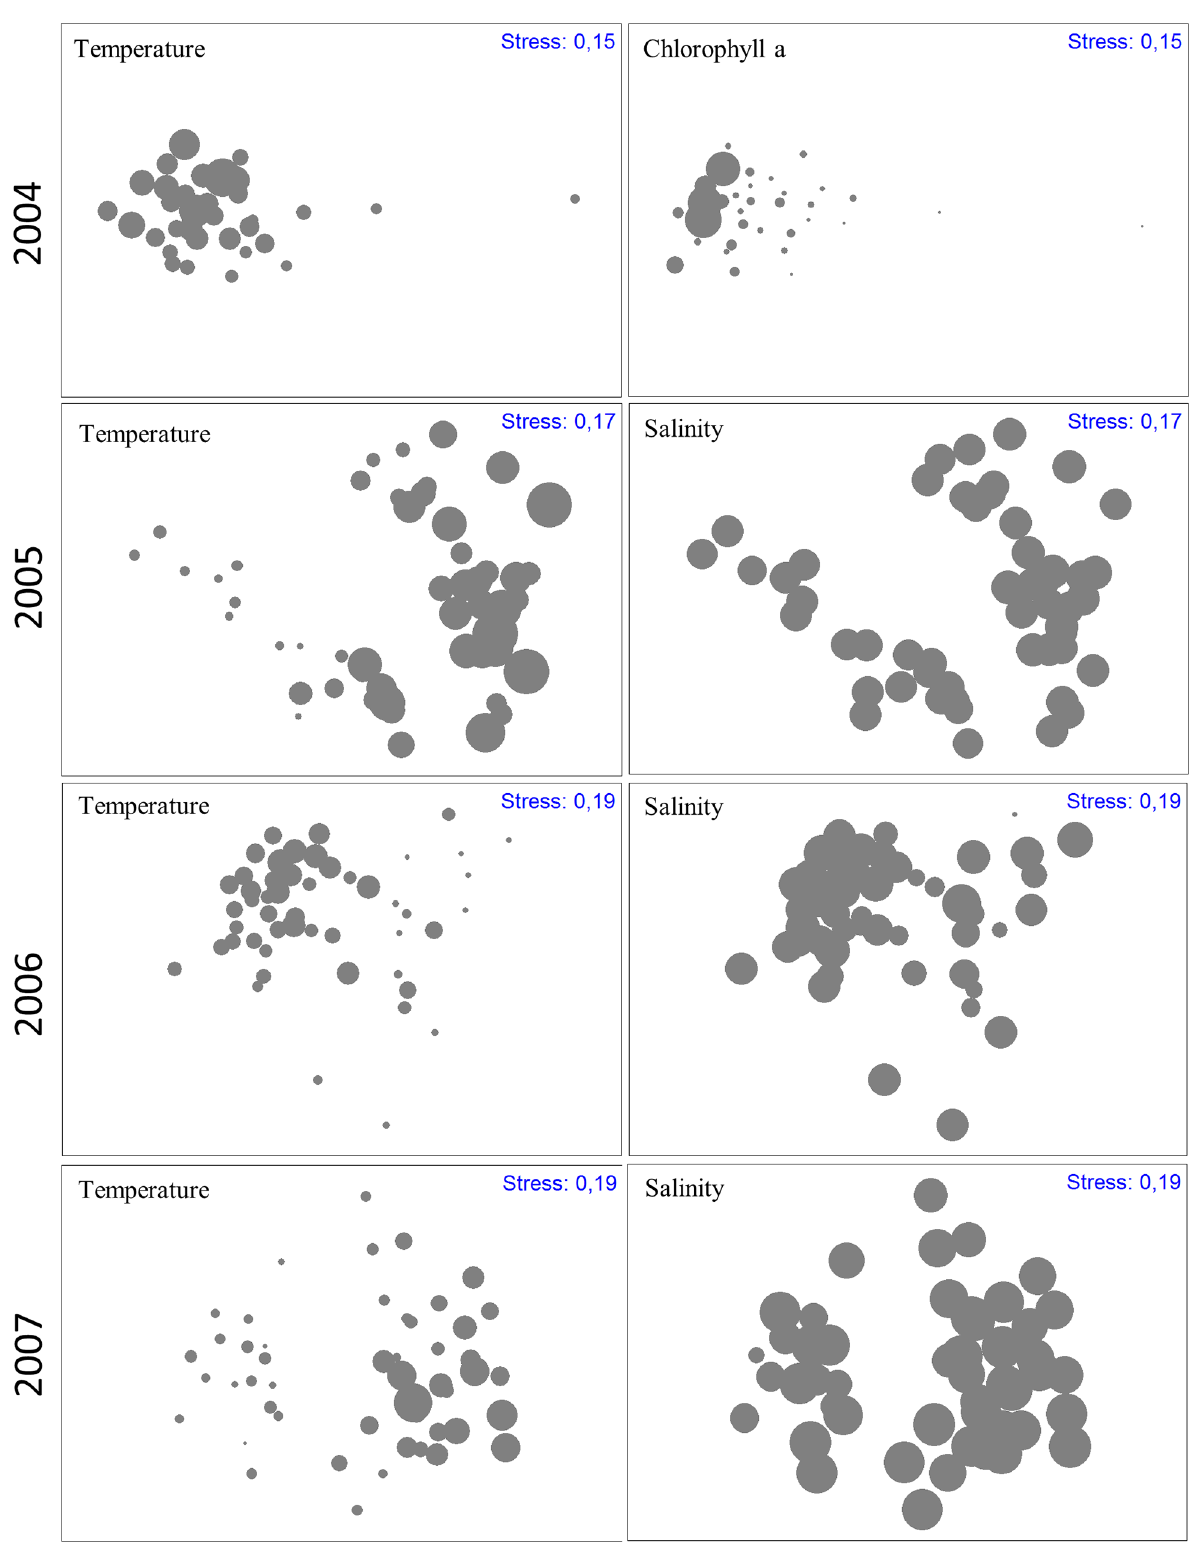
Fig 8. Environmental variables identified by BIO-ENV as the best correlated to the temporal changes in the phytoplankton assemblage. The abiotic variablesare superimposed onto the biotic MDS as bubbleswith varyingsizes; the larger the bubblethe greater the value of the superimposed